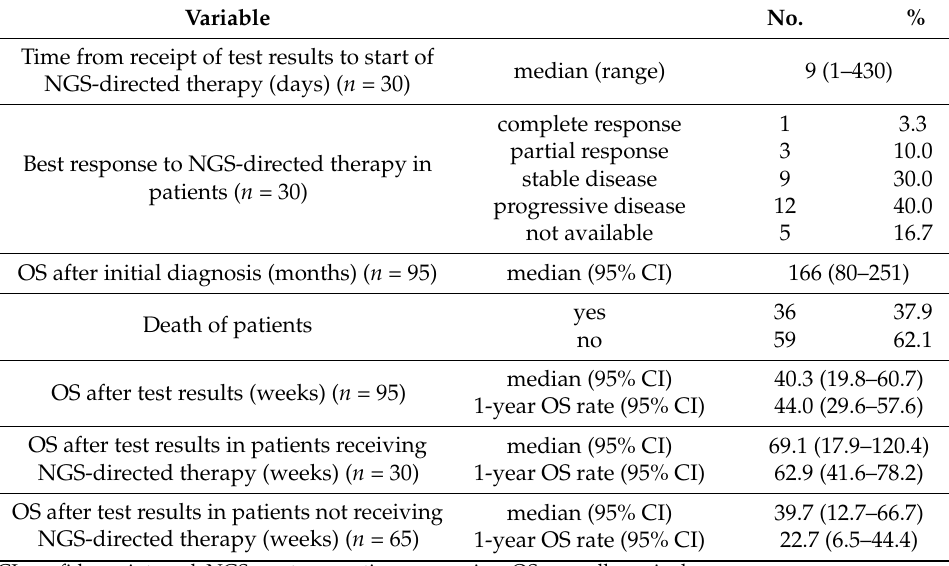
Table 3. NGS-based treatment and